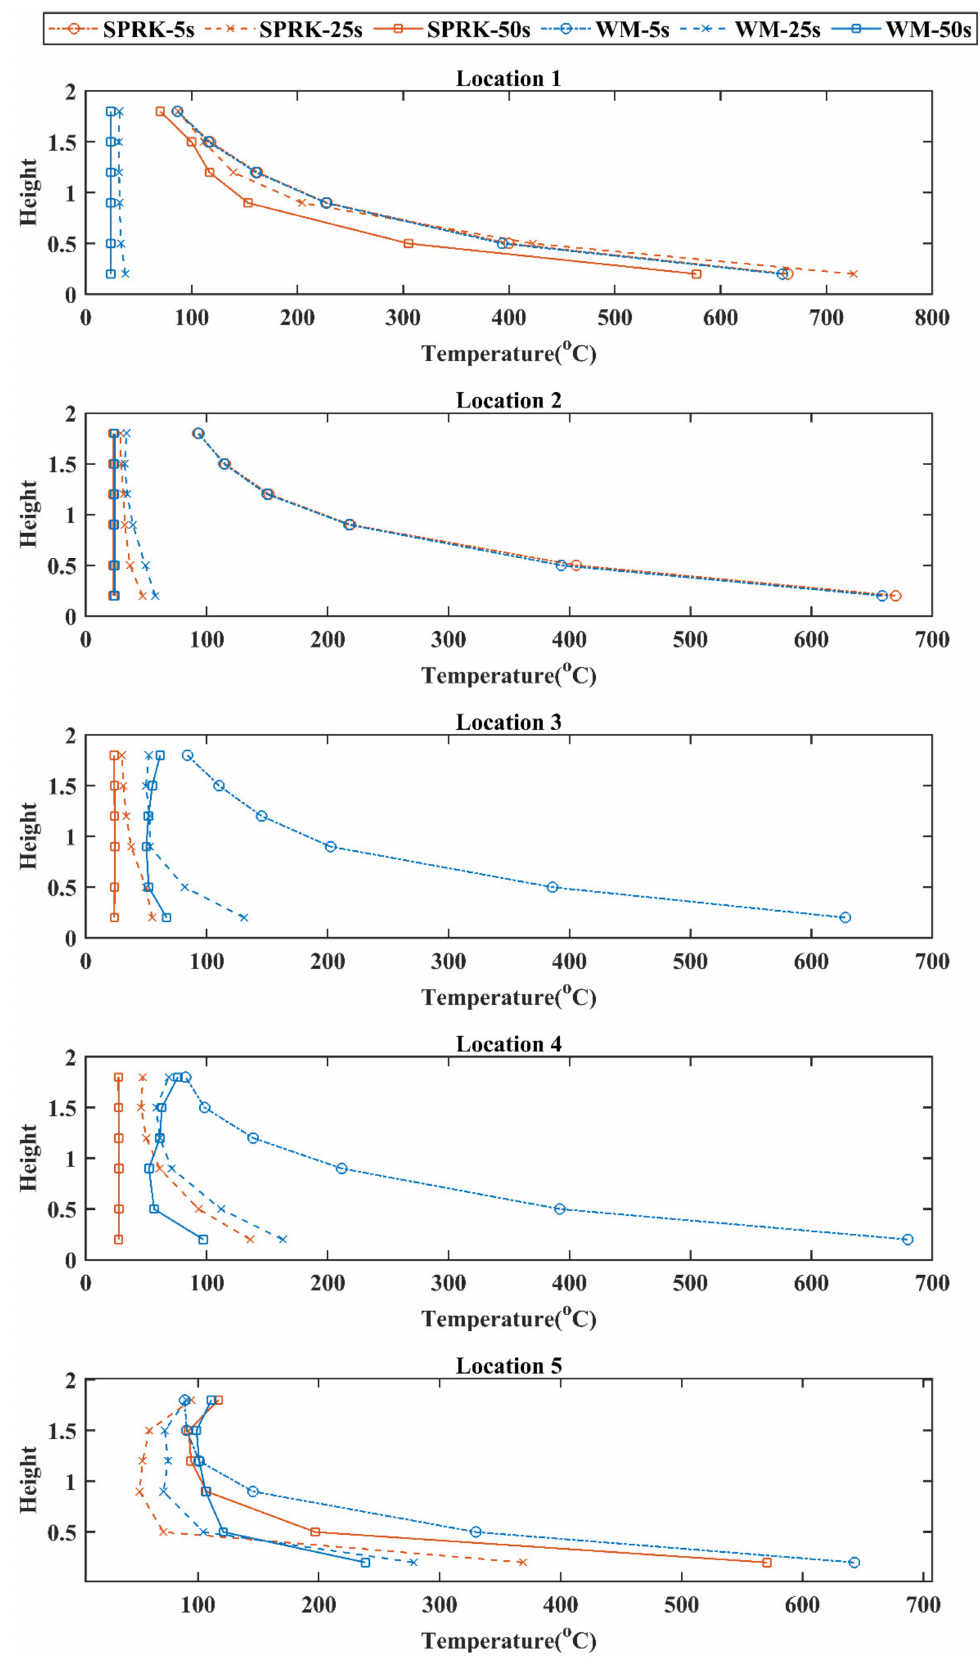
Figure 7. Temperature distribution along the height of the room for different fire suppression